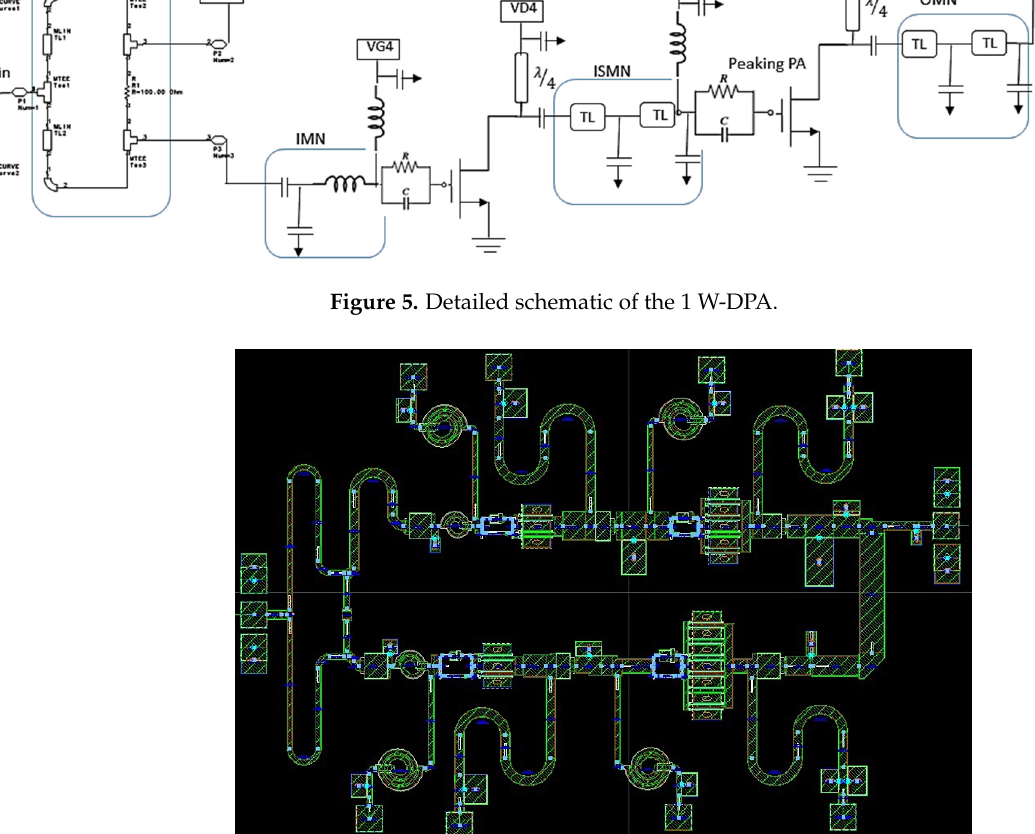
Figure 5. Detailed schematic of the 1 W-DPA.